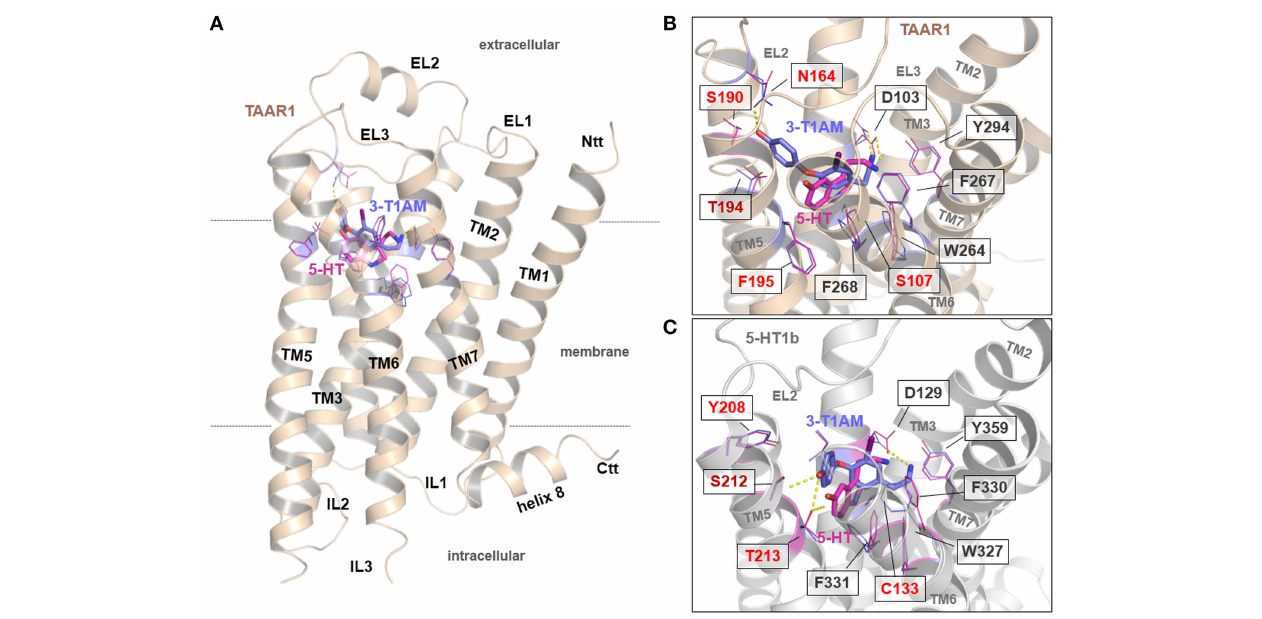
FIGURE 6 | General and detailed insights into potential binding modes of 3-T1AM and 5-HT at the hTAAR1 and the 5-HT1b. (A) This backbone illustration visualizes the general architecture of TAAR1. The principle ligand binding site and preferred ligand/receptor contact points are known (e.g., Cherezov et al., 2007; Tan et al., 2008; Vilar et al., 2011; Warne et al., 2011; Wichard et al., 2011). (B,C) Comparison of receptor side chains in both receptors covering the ligand binding-pockets revealed that essential residues are conserved, however, small deviations in the amino acid constitution of the binding pockets might be of significance (indicated by different coloring). 5-HT binds into TAAR1 in a comparable mode as supposed for 5-HT in the 5-HT1b. (B,C) . In the 5-HT1b/5-HT complex the ligand interacts with Thr213 in TMH5 via hydrogen bonding, which cannot be observed for 5-HT in TAAR1. It should be noted that 3-T1AM binds to the 5-HT1b in a nearly comparable way as was found for 5-HT (C) In TAAR1, the ligand 3-T1AM is located between the Asp103 in TMH3 and the aromatic moiety is located between TMH3-4-5, whereby according to these supposed complexes the hydroxyl-group interacts with Asn164 at the transition between the EC2 and TMH4 (B) . This is vastly different to 3-T1AM binding in the 5-HT1b (C) , which is reasoned by amino acids Ser190 (TAAR1) and Tyr208 (5-HT1b) at corresponding positions in TMH5. While the bulky aromatic ring of Tyr208 in 5-HT1b blockades the orientation of ligands between TMH3-4-5, in TAAR1 this region is accessible for the ligand because of the smaller serine side